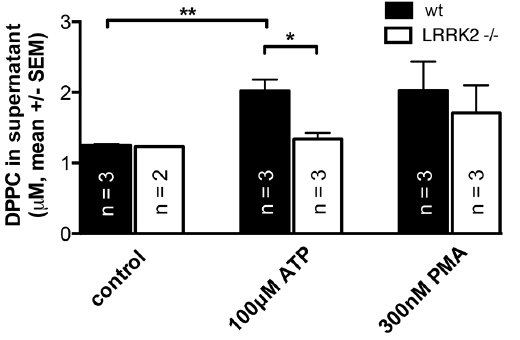
Figure 5. DPPC concentration in supernatant as a measure of surfactant secretion. DPPC concentration was measured in superna- tant of unstimulated cells and of cells stimulated with either 100 m M ATP or 300 nM PMA for 30 minutes. DPPC concentration in supernatant was significantly higher in wt cells following stimulation with 100 m M ATP.